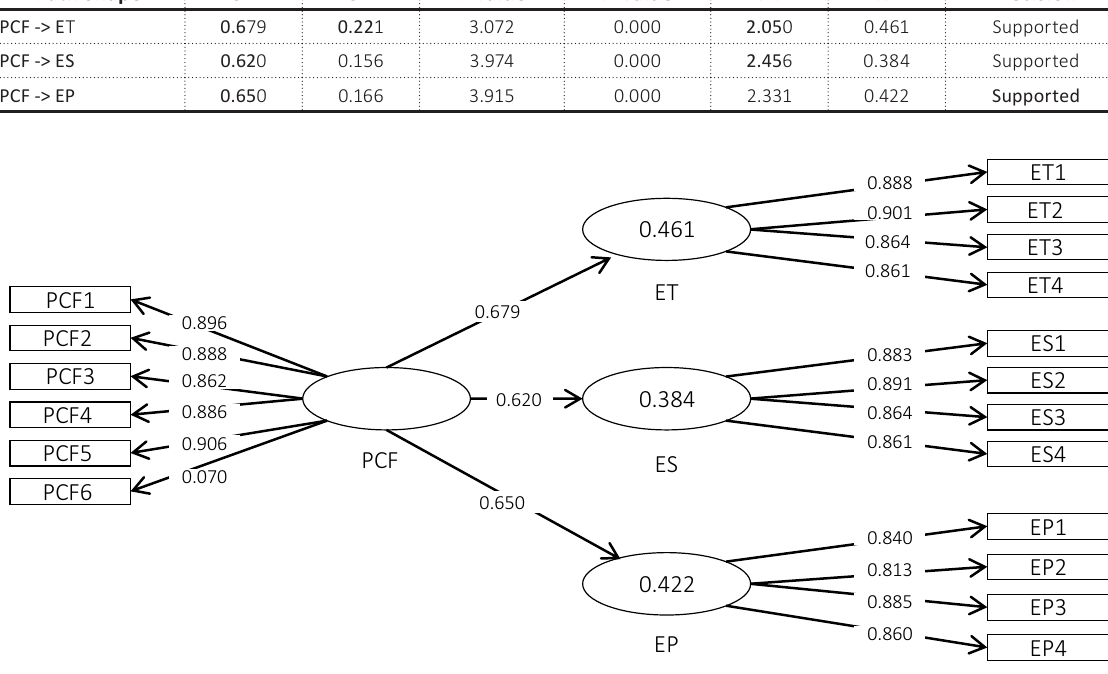
Figure 1. Validated research